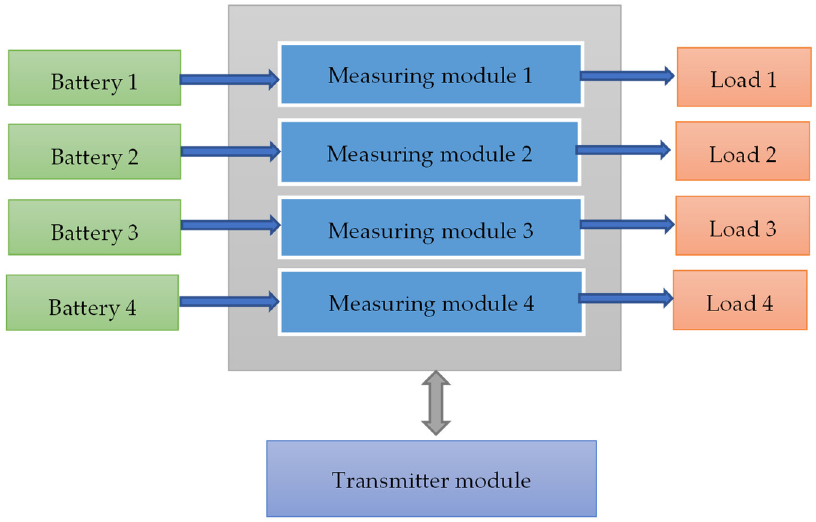
Figure 22. The operating principle of the measuring device.